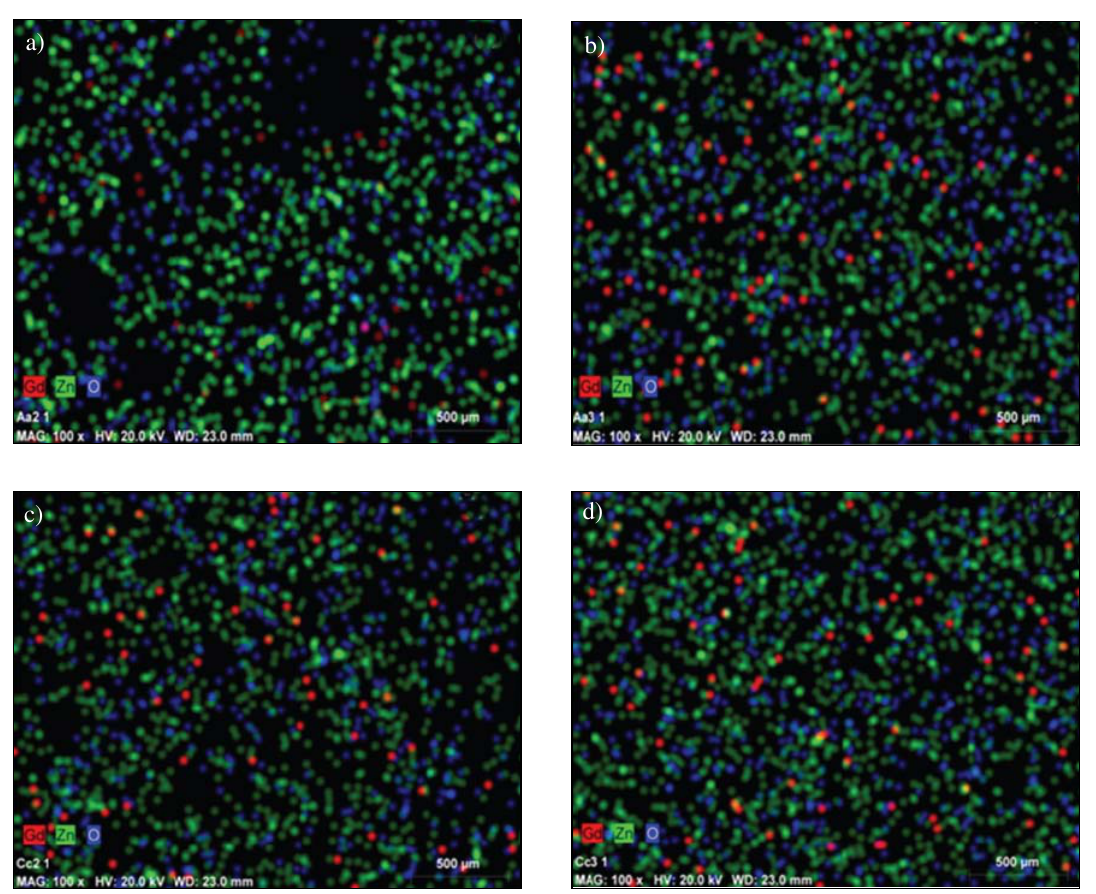
Figure 6. Elemental mapping of (a) 1.0 mol% Gd doped ZnO (CTAB) (b) 1.5 mol% Gd doped ZnO (CTAB) (c) 1.0 mol% Gd doped ZnO (PVP) (d) 1.5 mol% Gd doped ZnO (PVP).